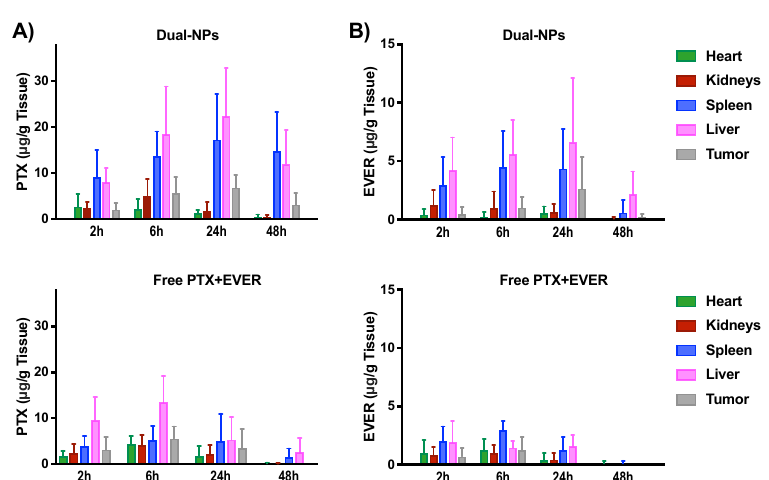
Figure 2. Tissue distribution of ( A ) paclitaxel (PTX) and ( B ) everolimus (EVER) in female Nonobese diabetic / severe combined immunodeficiency (NOD / SCID) mice bearing MDA-MB-231-H2N BC xenografts (HER2 mod / EGFR mod ) after single intravenous administration of dual-targeted PTX + EVER-loaded nanoparticles (Dual-NPs) or free PTX + EVER combination at a PTX-equivalent dose of 15 mg / kg and EVER-equivalent dose of 7.5 mg / kg. ( n = 5).